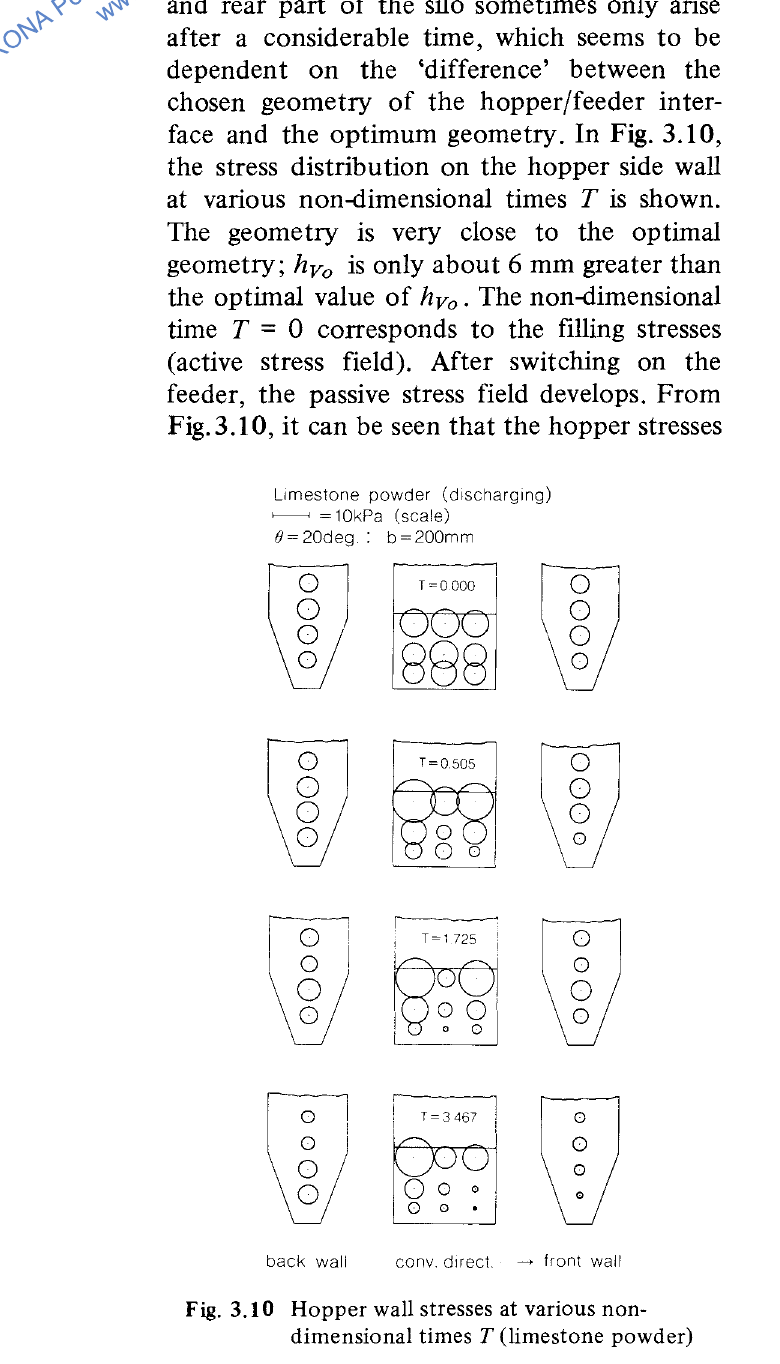
Fig. 3.10 Hopper wall stresses at various non dimensional times T (limestone powder) remain quite even until T = 0.5 (i.e. discharge